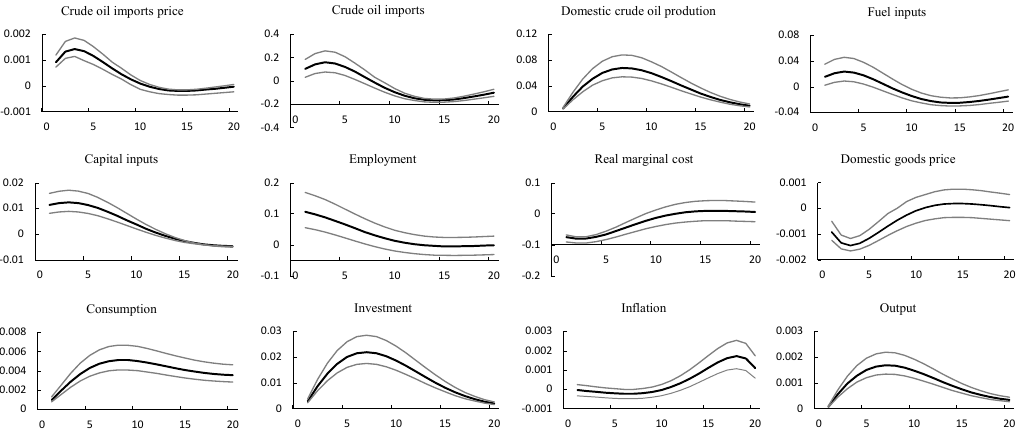
Figure 5. Positive economic demand shock. (Note: The black solid line represents the estimated actual mean responses, and the gray solid lines represent the 5 percent and 95 percent posterior interval).